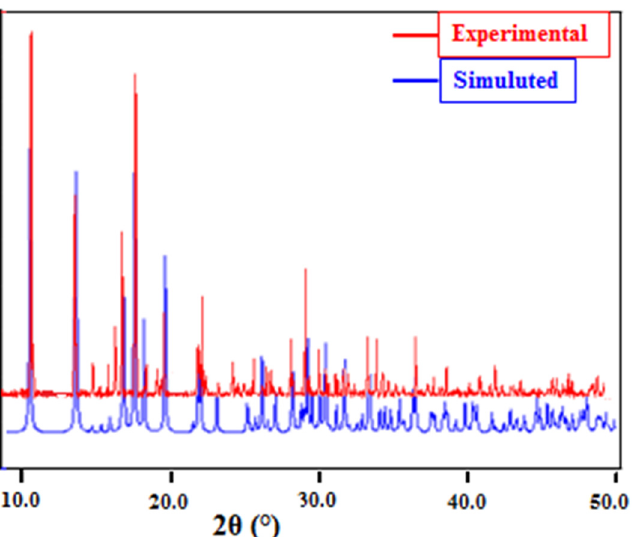
Figure 1. Experimental powder XRD pattern of (C 5 H 14 N 2 )[HgCl 4 ] · H 2 O compared with theoretical PXRD pattern.